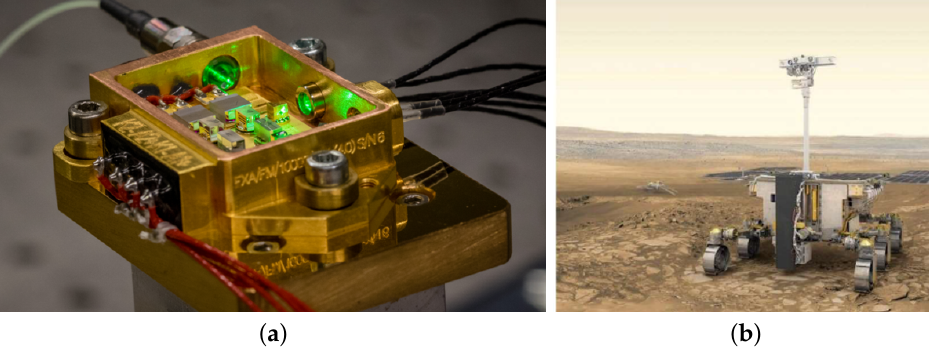
Figure 10. ( a ) A final FM assembled laser. ( b ) Photo: ESA/ ATG medialab. Schematic of the ExoMars Rover (named Rosalind Franklin) which contains the ExoMars laser